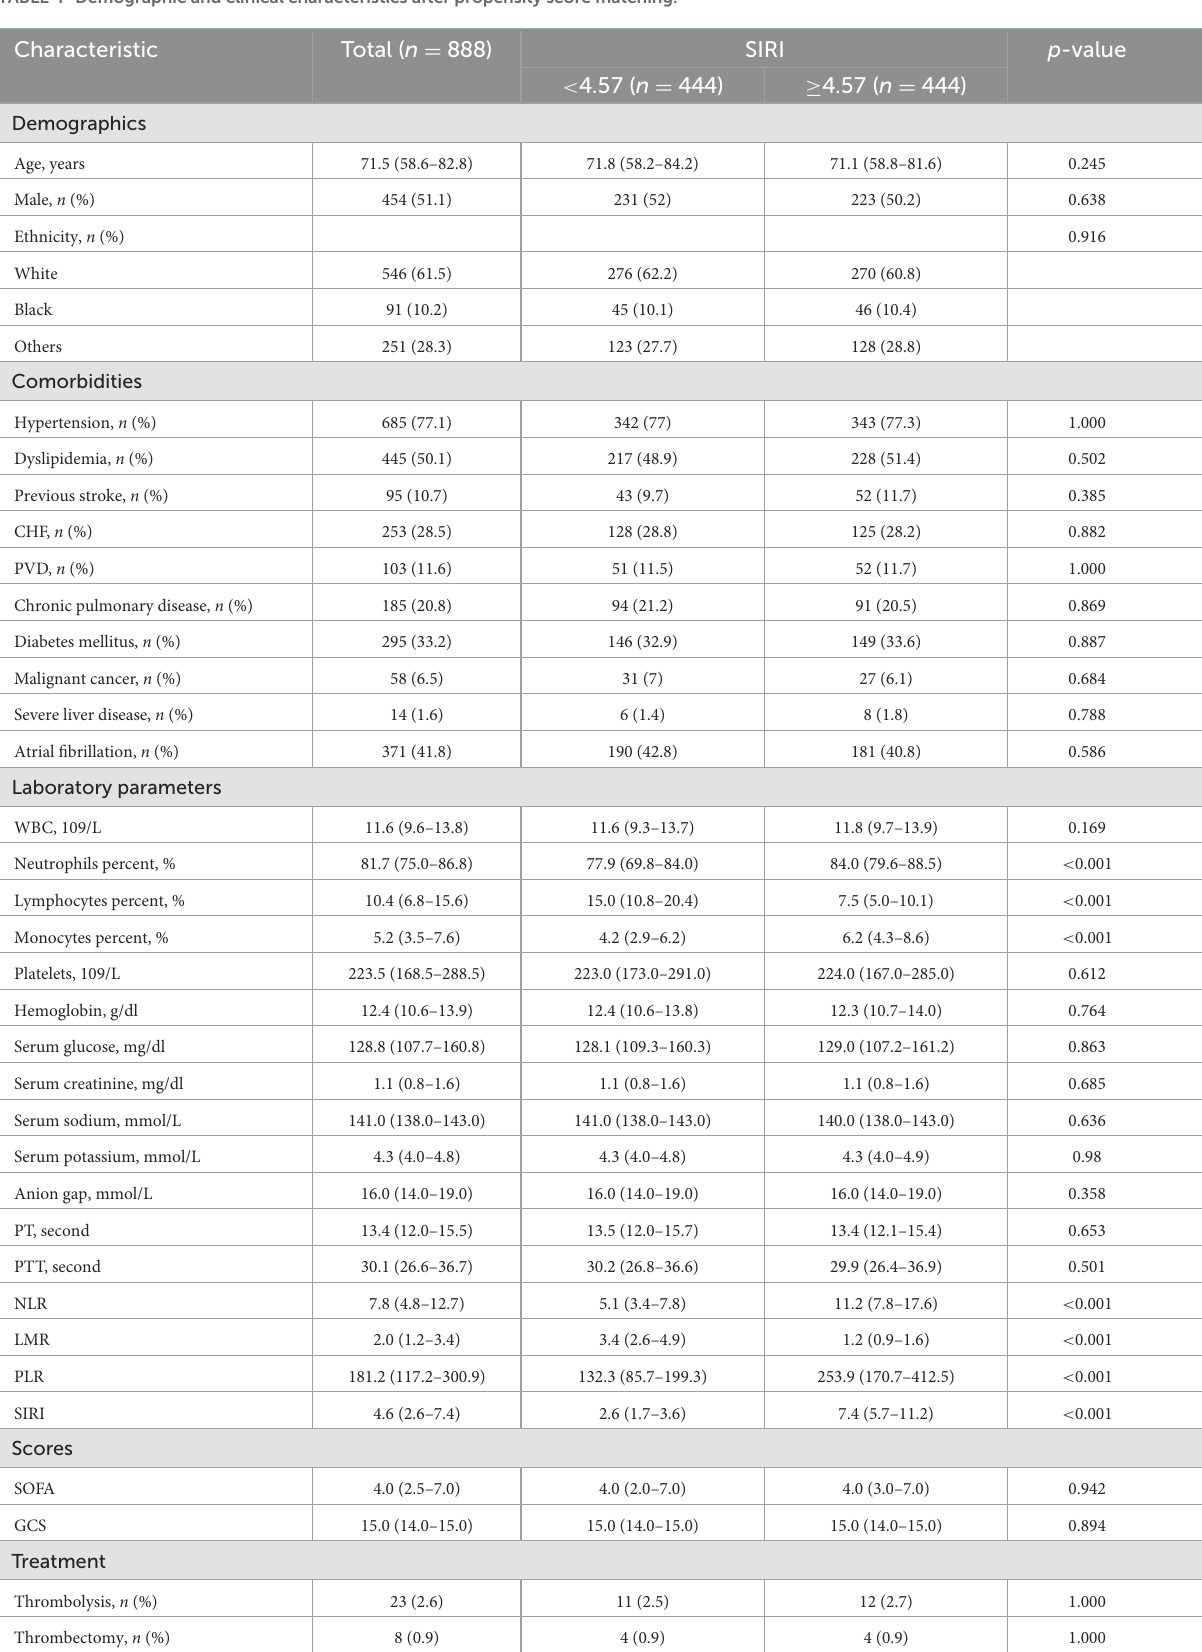
TABLE 4 Demographic and clinical characteristics after propensity score matching.